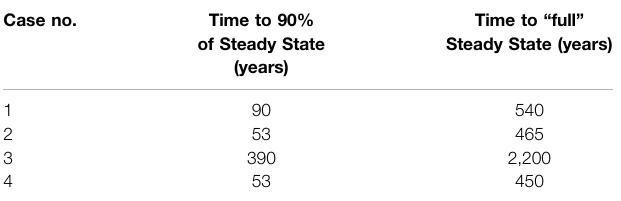
TABLE 3| Thenumber ofyearstaken forthe system toreachsteadystate ineach case, for a sediment column of 4 m. We note that this is the same regardless of the amount of recycling taking place because the exchange reaction does not affect sulfate concentrations. Case